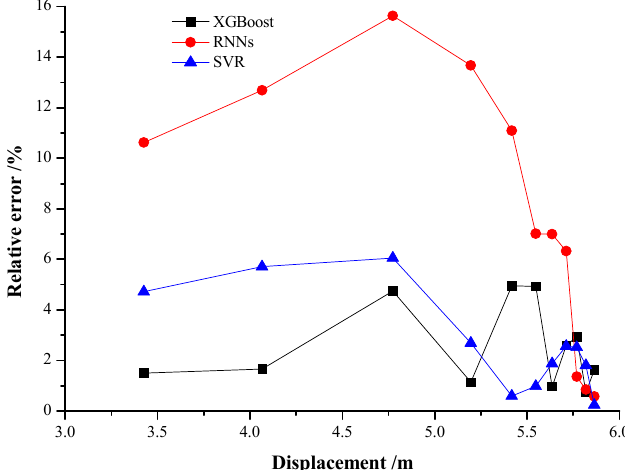
Figure 14. Variation of RE with slope displacement of D8.